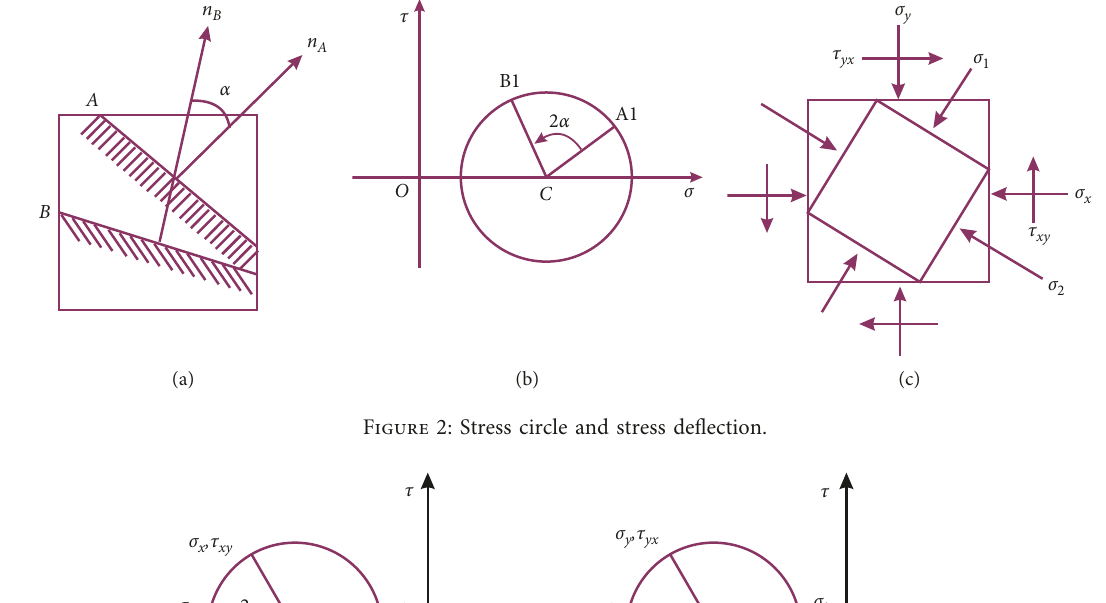
Figure 2: Stress circle and stress deflection.